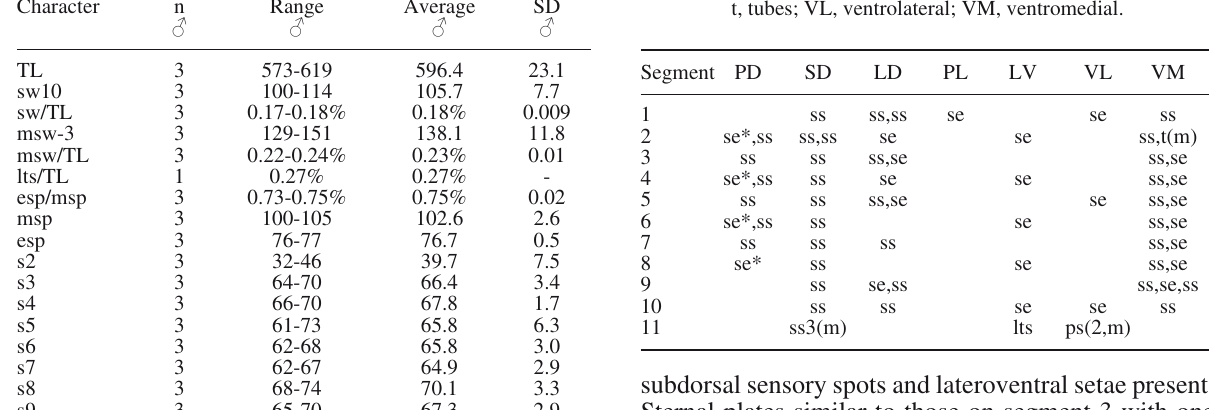
t able 3. – Measurements (µm) of adult Pycnophyes chalgap n. sp.; esp, episternal plate; lts, lateral terminal spine; msp, midsternal plate; msw-3, maximum standard width of segment 3; n, number of measured specimens; SD, standard deviation; sw, standard width;